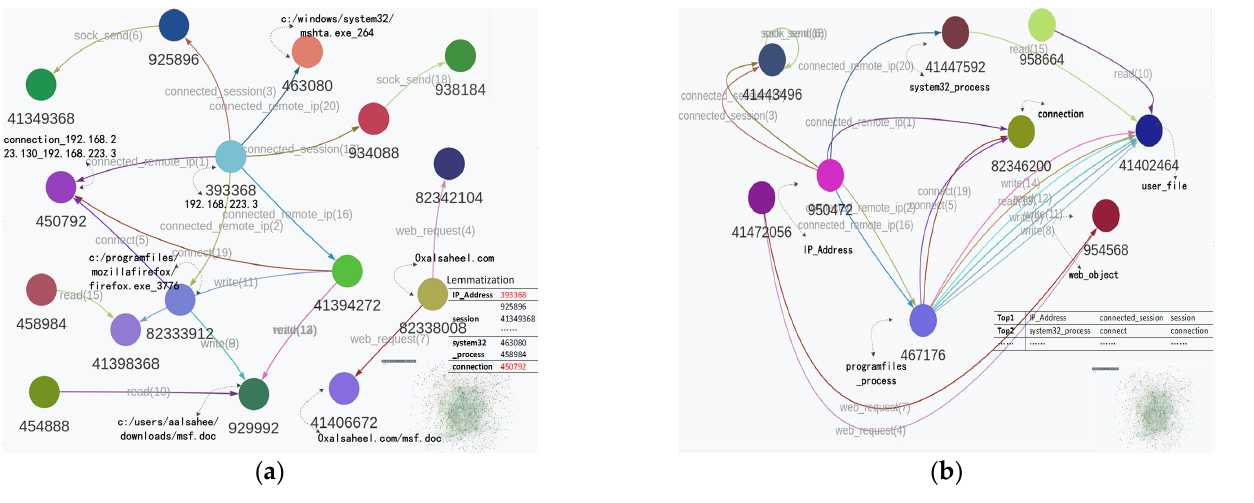
Figure 10. Case study based on a neighborhood graph. This is an example of malicious event prediction based on neighborhood graph and a temporary ID was randomly generated for each node. Compared to the example given in Figure 9, it contains more attack information. ( a ) The original neighborhood graph. ( b ) The neighborhood graph after lemmatization.